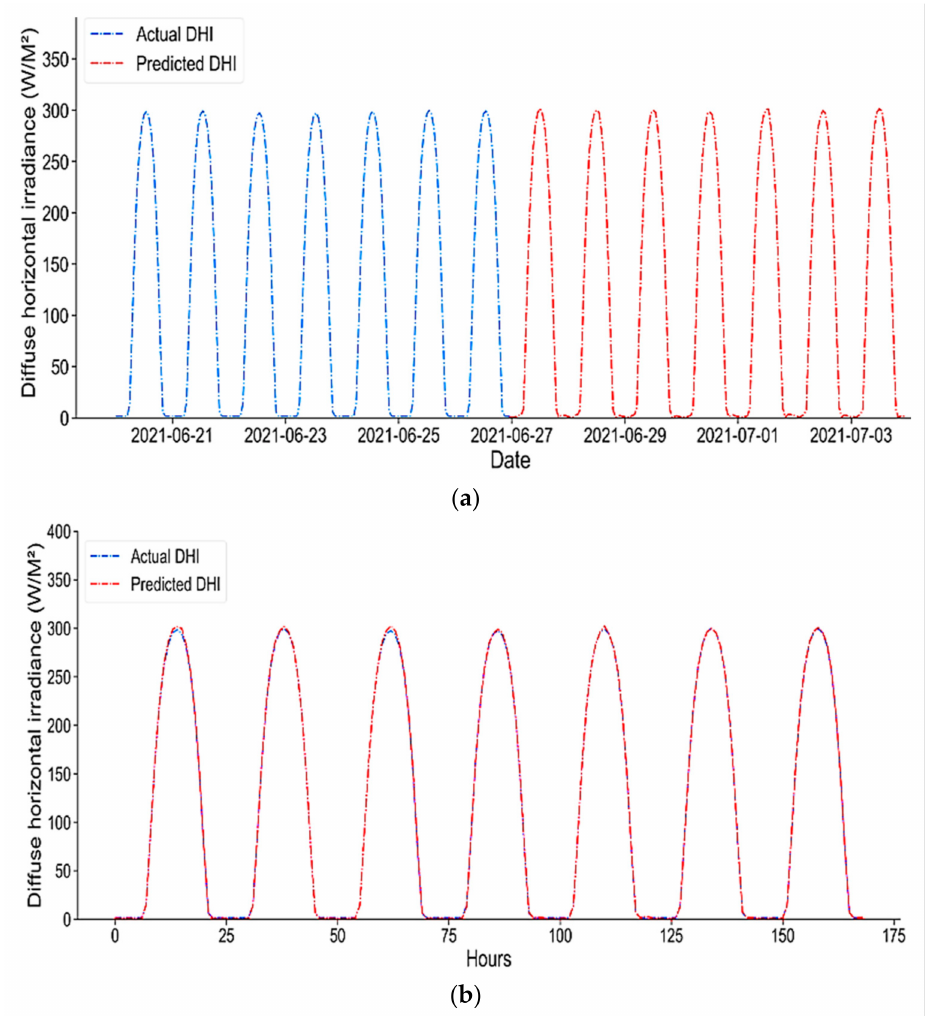
Figure 20. ( a ) The real and predicted values of DHI, which show the fit and performance of the BI-LSTM model; and ( b ) the DHI’s predicted future values for the next 169